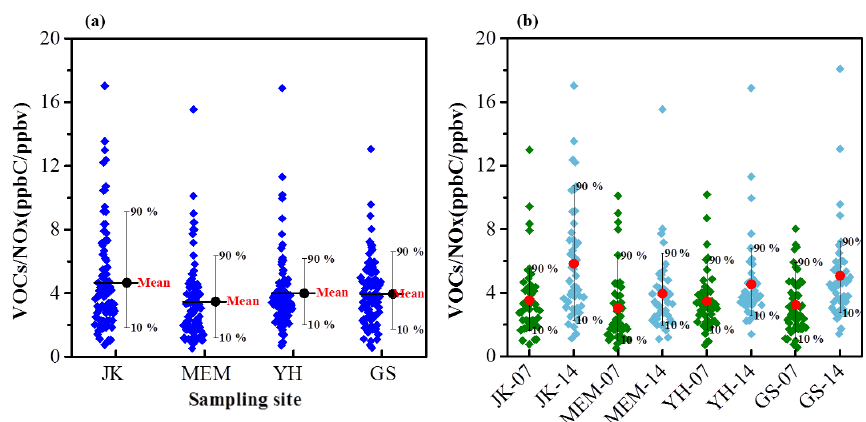
Figure 10. The data distribution of VOCs / NO x (ppbCppbv − 1 ) at the four sites (a) , and the ratio observed at 07:00 and 14:00LT (b) .